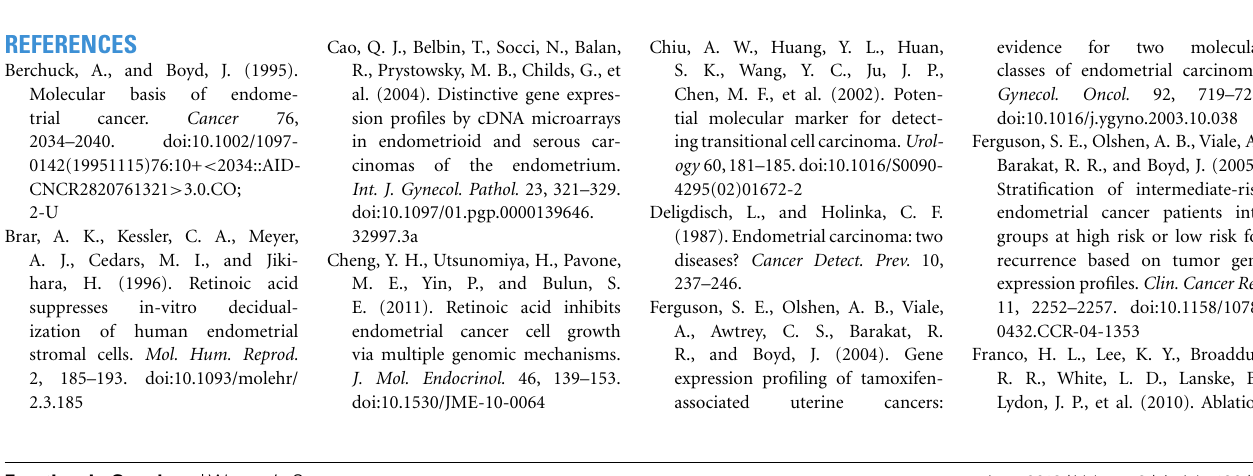
Figure S1 |Transcript expression from quantitative PCR (top row) and microarray analysis (bottom row) for six selected genes (RORB, PEG3,TRH, S100A8, MELK, and DLG7) differentially expressed between endometrial carcinoma endometrioid (E), papillary serous carcinoma (PS), and normal endometrium